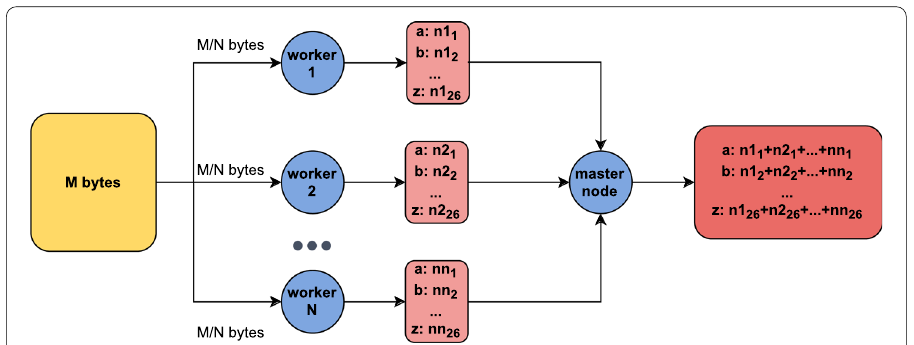
Fig. 7 Architecture of the proposed MPI